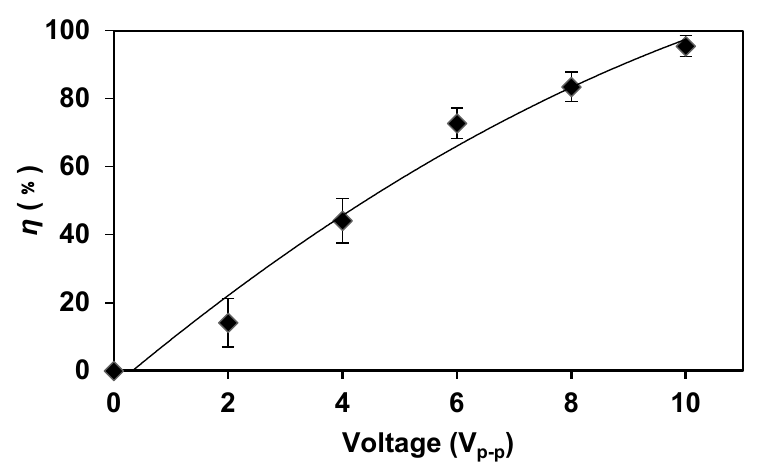
Figure 4. The higher voltage can better break down the bacteria to accelerate the lysis process compared with lower voltages. When the voltage was increased, the lysis efficiency was increased. The frequency was kept at 5 MHz and the flow rate was kept at 2 μ L/min.